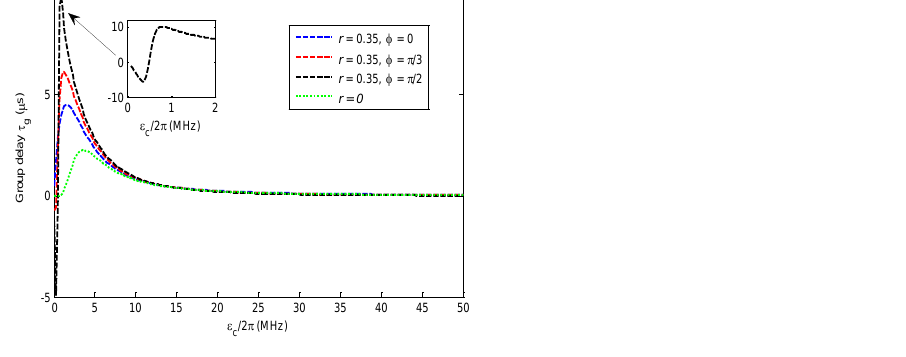
Figure 5. Curves of group time delay τ g vary with the pump-field amplitude ε c /2 π and driving field amplitude at ∆ / ω m = 0.99 for different phase differences. The other parameters are the same as those in Figure 2.